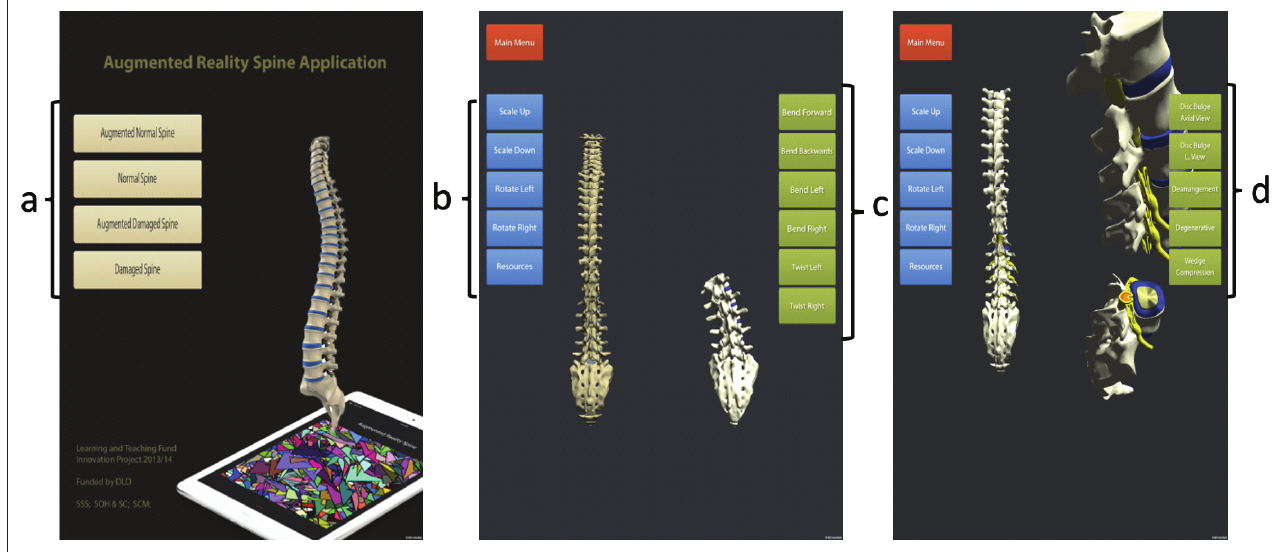
FIGURE 2: Screenshots of the mobile application depicting (1) the normal structure and function of the spine and (2) various pathologies of the spine. (a) The students were able to choose different modes (from learning about the normal spine to learning different pathologies) within the App. (b) Using the tabs on the left column, students were able to view the spine in all planes. (c) Using the tabs on the right-side column, students were able to explore the biomechanics of different spinal movements in different planes. (d) Using the tabs on the right column, students were also able to explore different clinical conditions of the